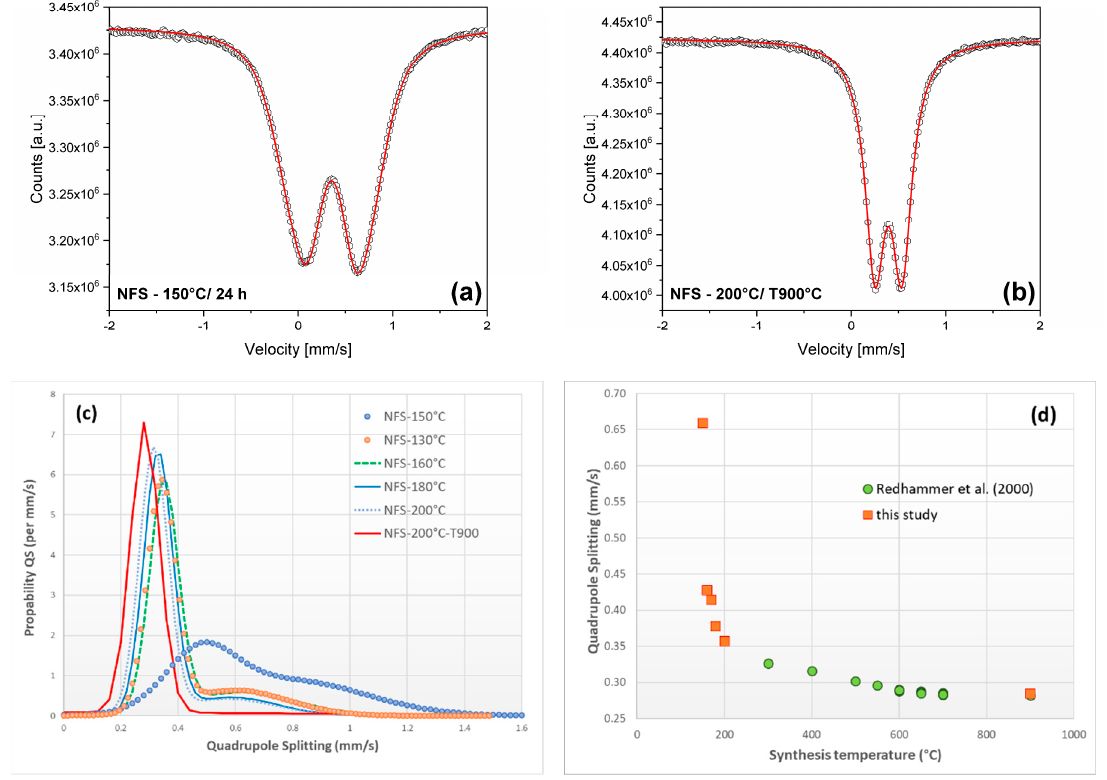
Figure 8. Selected 57 Fe Mössbauer spectra of NaFeSi 2 O 6 , synthesized at ( a ) 150 ◦ C and 24 h, ( b ) at 200 ◦ C, with an additional heat treatment at 900 ◦ C for 24 h. ( c ) shows the extracted Fe 3 + quadrupole splitting distribution and ( d ) gives the variation of weighted average Fe 3 + quadrupole splitting as a function of synthesis conditions. Table 2. 57 Fe Mössbauer parameter for the aegirines, synthesized in this study.